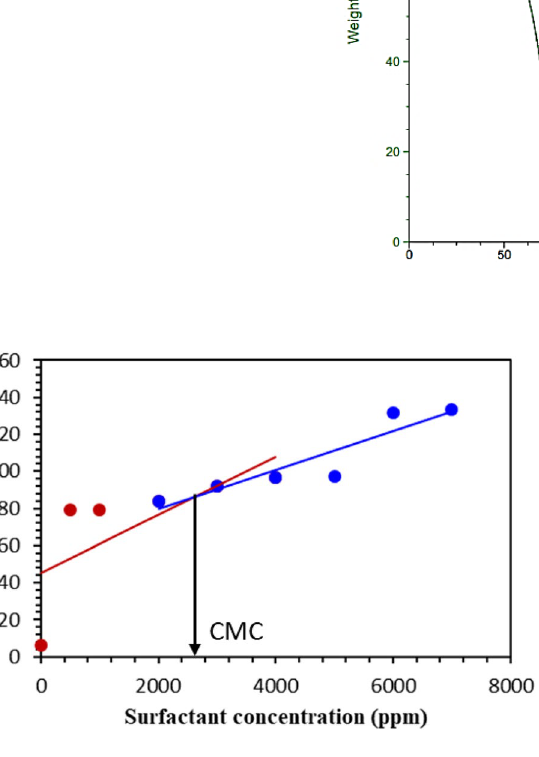
Fig. 9 CMC of the Vitagnus surfactant estimated using the conduc- tivity